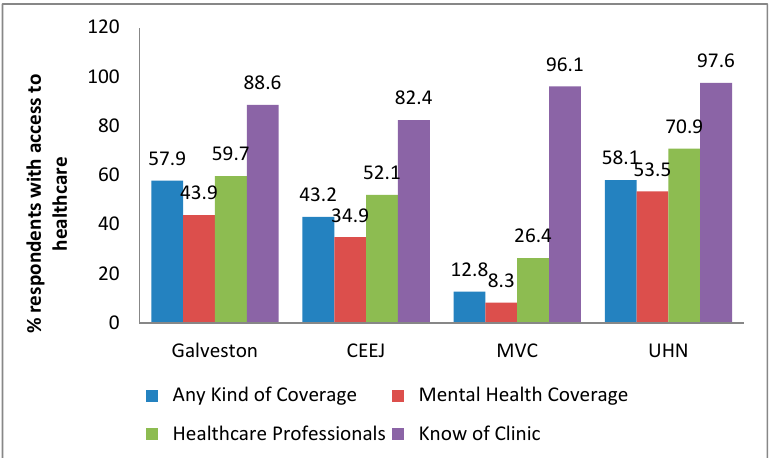
Figure 2. Access to healthcare. Questions related to access to health care coverage and access to a clinic or health care provider reveal disparities across communities.